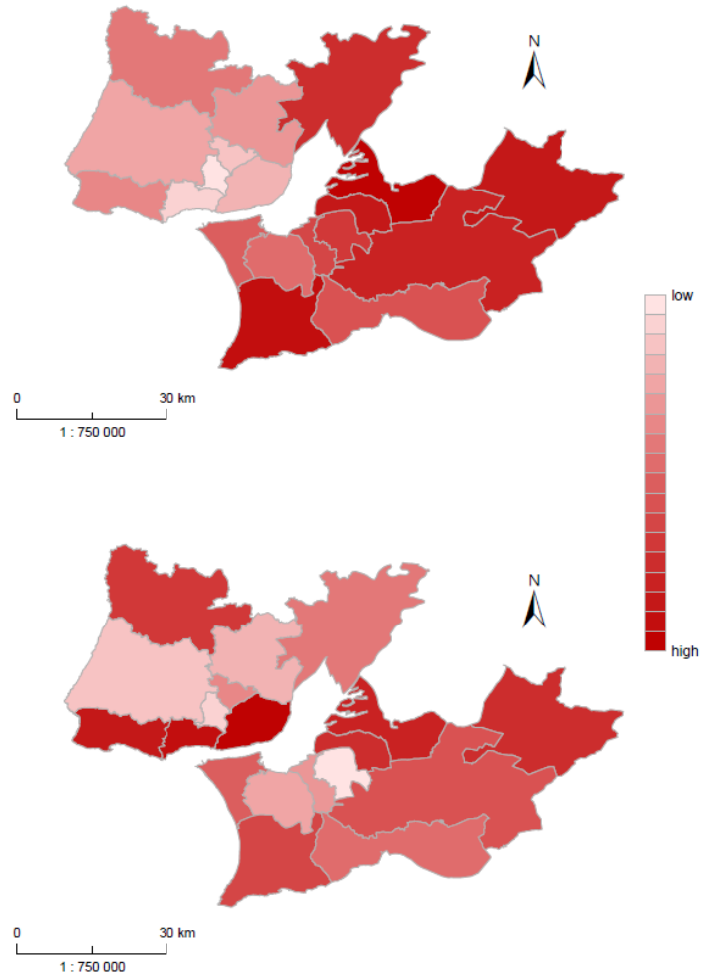
Figure 4. ( A ) High mortality & social and housing deprivation factor score in Lisbon MA. ( B ) Low mortality & economic, social, and housing prosperity factor score in Lisbon MA.